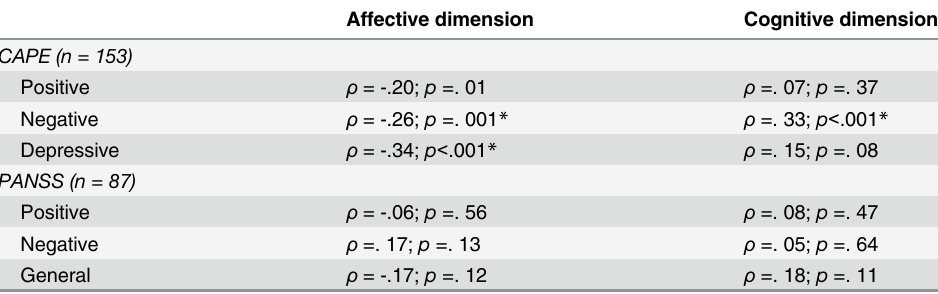
Table 4. Correlations between the two alexithymia dimension and psychotic symptoms. Affective dimension Cognitive dimension CAPE (n =